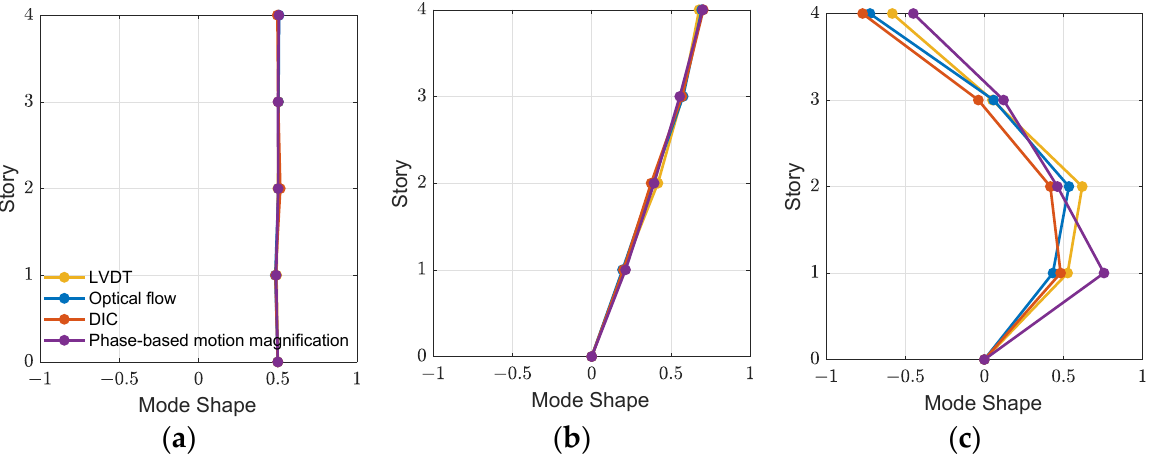
Figure 10. Identified mode shapes: ( a ) rigid-body mode; ( b ) 1st mode; ( c ) 2nd mode. Table 4. Comparison of modal properties using the proposed three approaches.